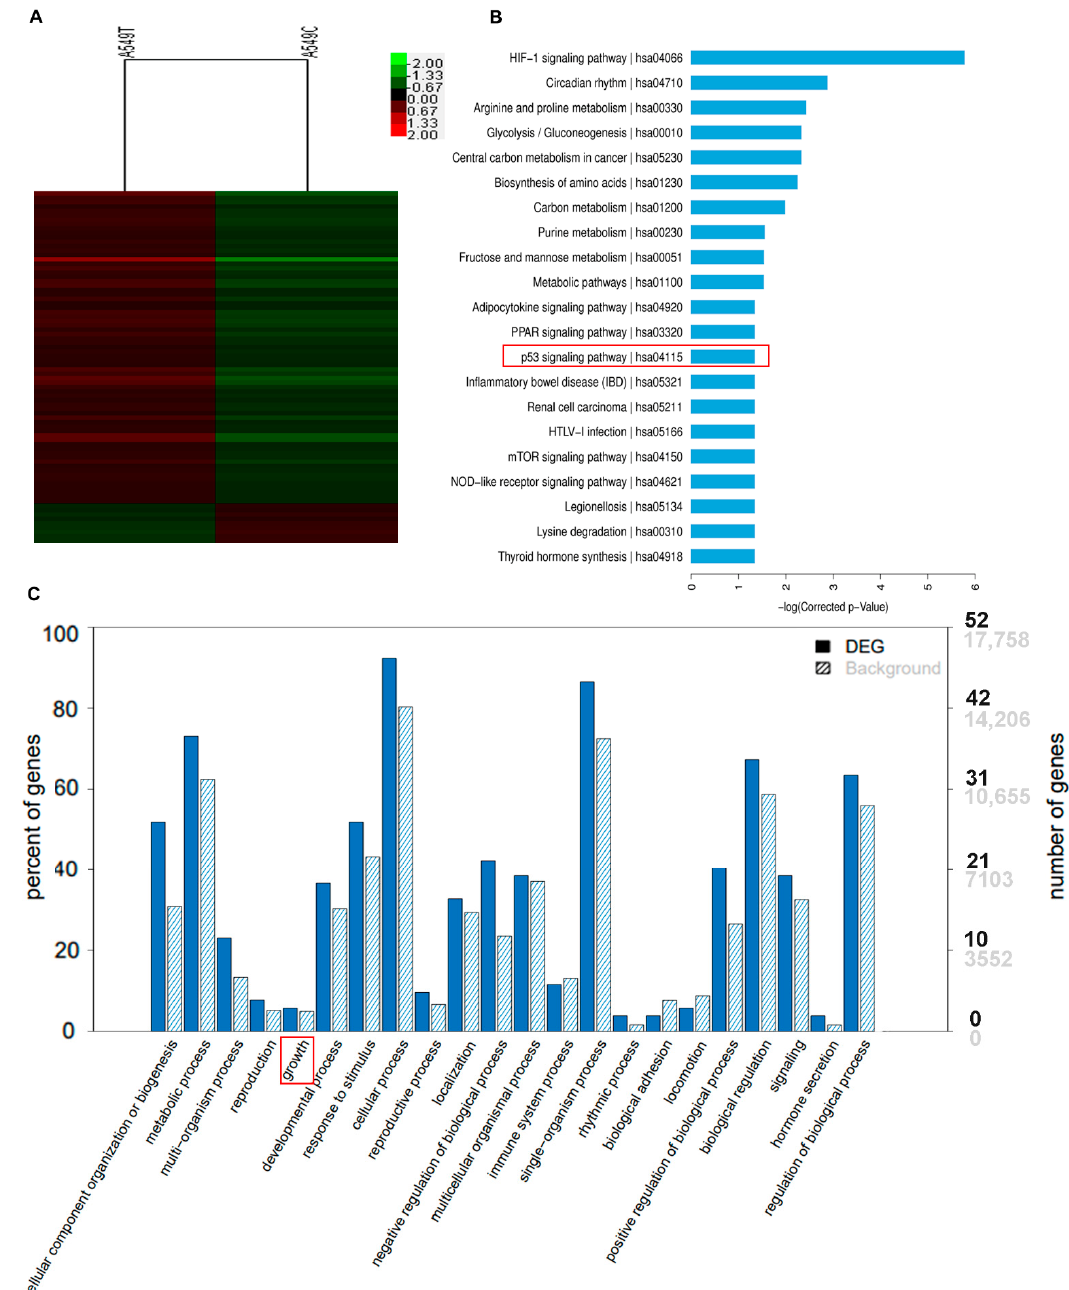
Figure 5. FPD5-treated A549 cell line for PrimeView Human Gene Expression Array. ( A ) Heatmap of differentially expressed genes in A549 cell line. ( B ) KEGG pathway enrichment analysis in A549 cell line. The red frame indicated the genes involve in the p53 signaling pathway. ( C ) GO enrichment classification map of genes regulated by ESD. The red frame indicated the genes involve in cell